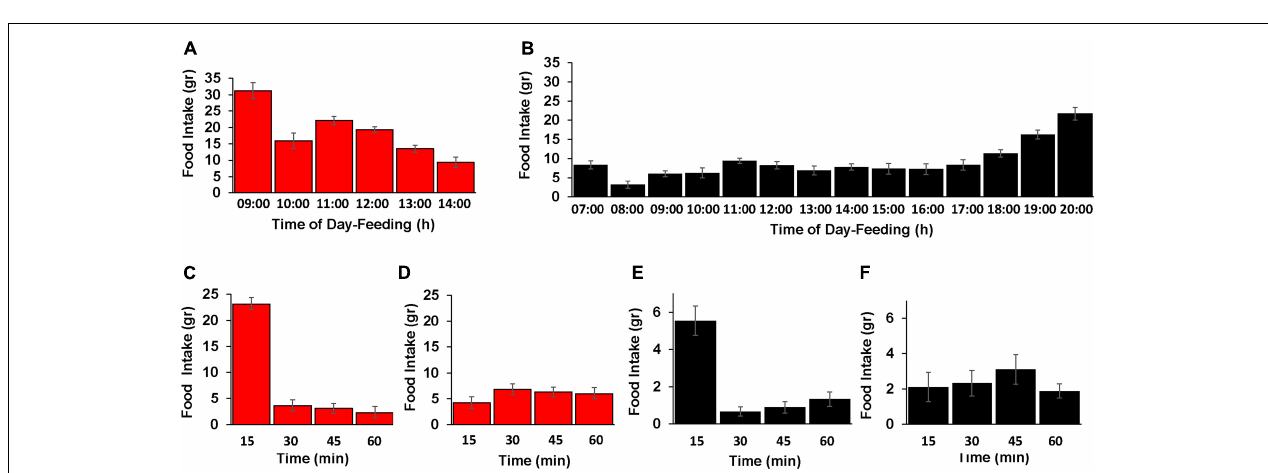
FIGURE 4 | Effect of the TRF on the diurnal pattern of feed-consumption behavior. (A,B) Food consumption of the control (CON; black color) and TRF-treated birds (red color) during hour intervals of the free-feeding periods. TRF-treated birds had free access to food between 08:00 and 09:00 h. Control birds consumed food along the lighting time: 06:00–20:00. Each hour period is indicated by the end time (e.g., 08:00–09:00 is indicated by 09:00). (C–F) Food intake measured in 15-min intervals for the first and third hours (08:00–09:00 and 11:00–12:00 h, respectively) of eating for the TRF-treated birds (red color) and for the first and fifth hours of eating for the control group (black color, 06:00–07:00 and 11:00–12:00–h, respectively). Vertical lines represent scanning electron microscope. N = 28 in each